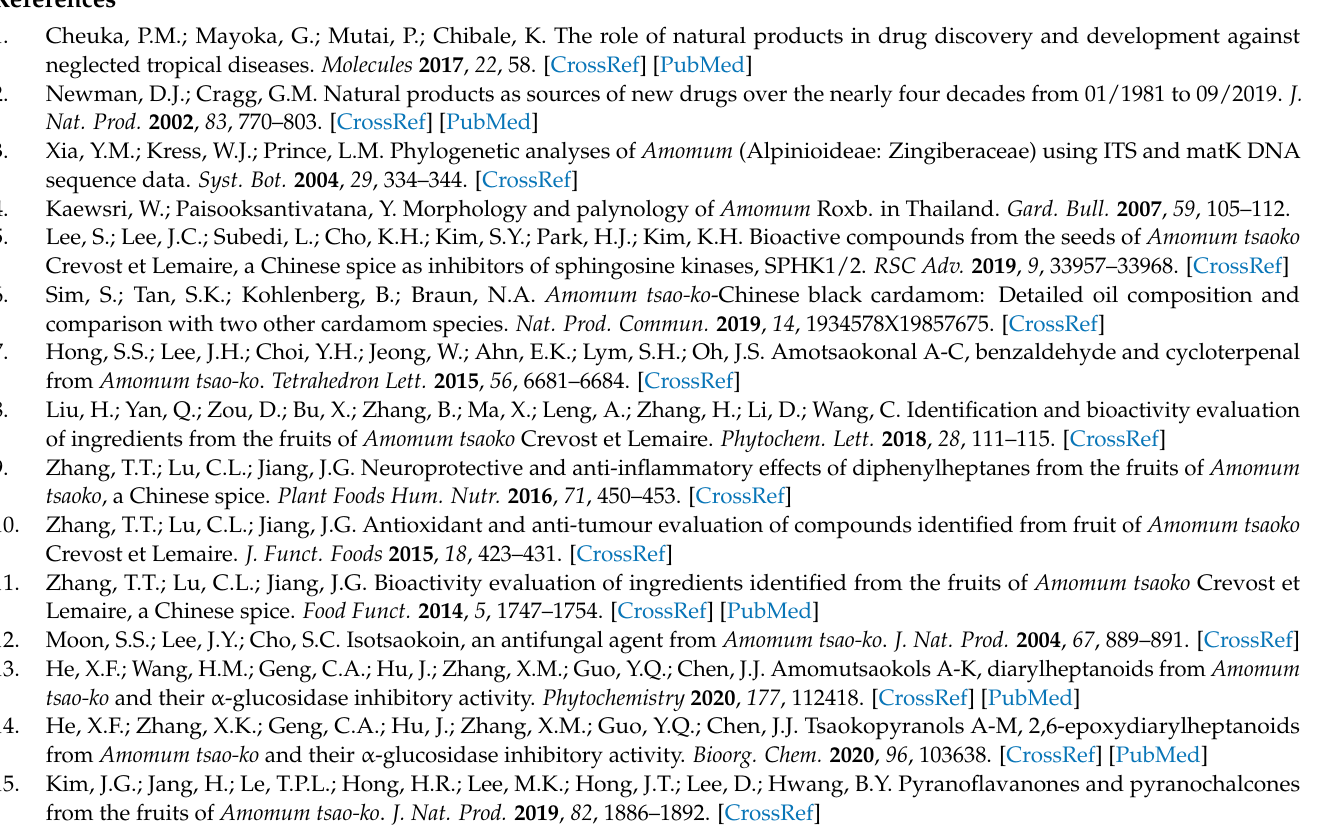
C NMR spectrum of 2 , Figure S6: 1 H NMR spectrum of 3 , Figure S7: 13 C NMR spectrum of 3 , Figure S8: 1 H NMR spectrum of 4 , Figure S9: 13 C NMR spectrum of 4 , Figure S10: 1 H NMR spectrum of 5 , Figure S11: 13 C NMR spectrum of 5 , Figure S12: 1 H NMR spectrum of 6 , Figure S13: 13 C NMR spectrum of 6